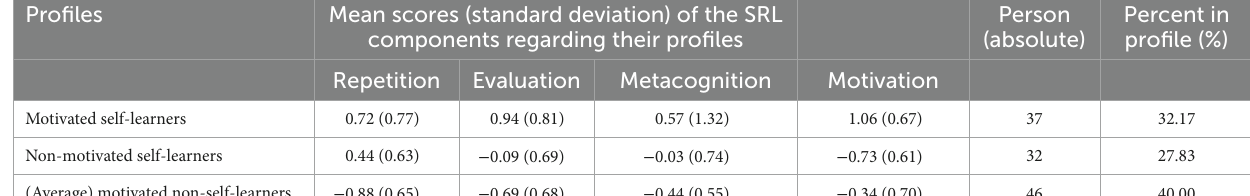
TABLE 4 Three-cluster solution with mean scores for the quality characteristics and the specification of absolute and relative (in percentage) numbers of students in the clusters. Profiles Mean scores (standard deviation) of the SRL components regarding their profiles